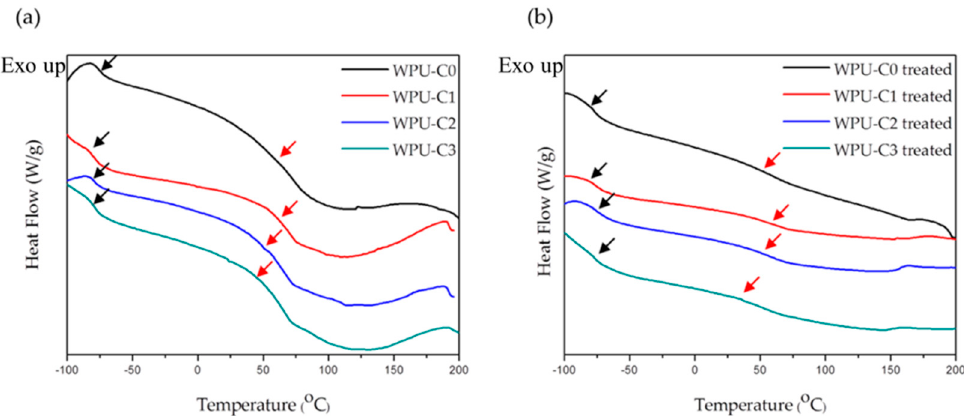
Figure 3. Differential scanning calorimetry (DSC) thermograms for waterborne polyurethane (WPU) films after drying ( a ) and after heat treatment for 24 h at 110 ° С ( b ).